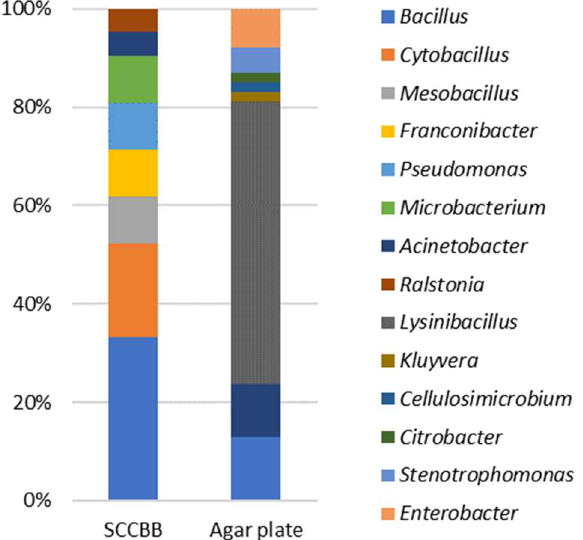
Figure 3. Taxonomic comparison of strains isolated using SCCBB and agar plate methods.